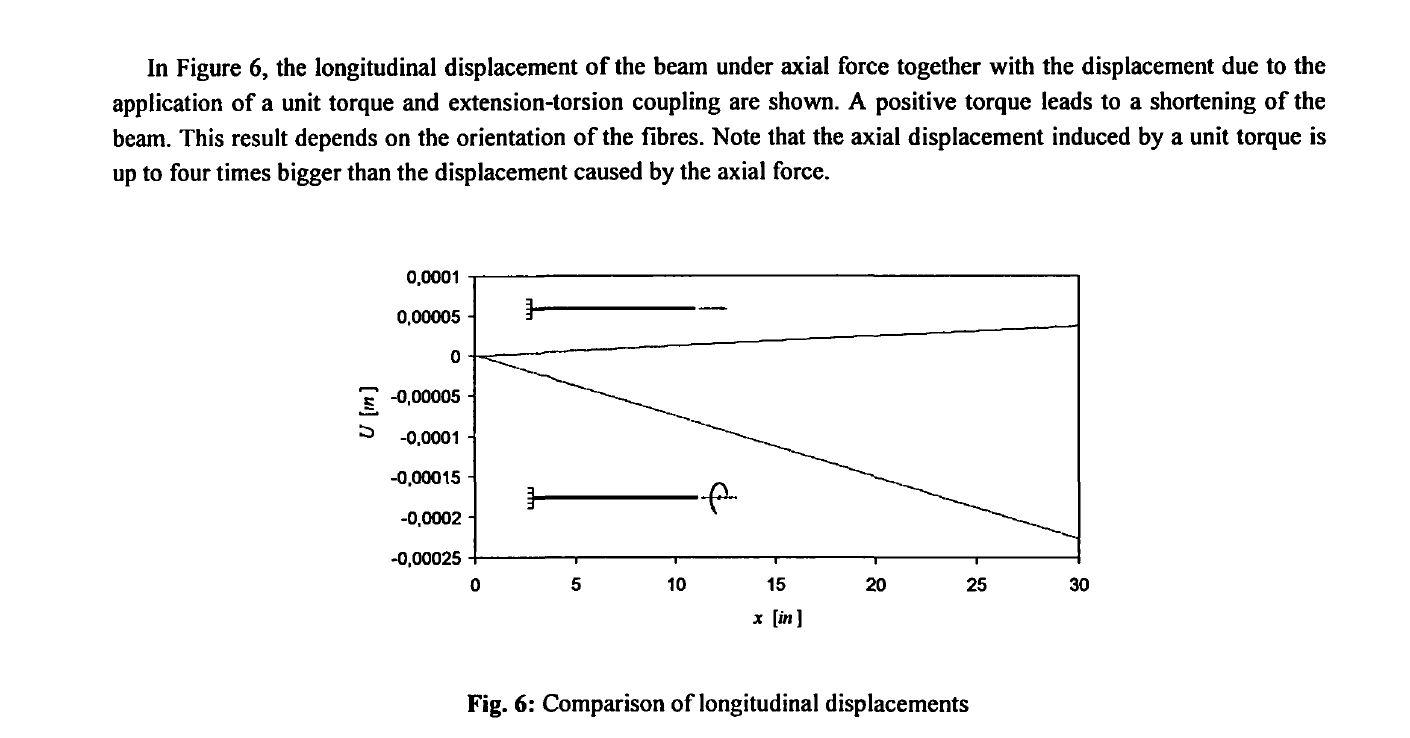
Fig. 6: Comparison of longitudinal displacements